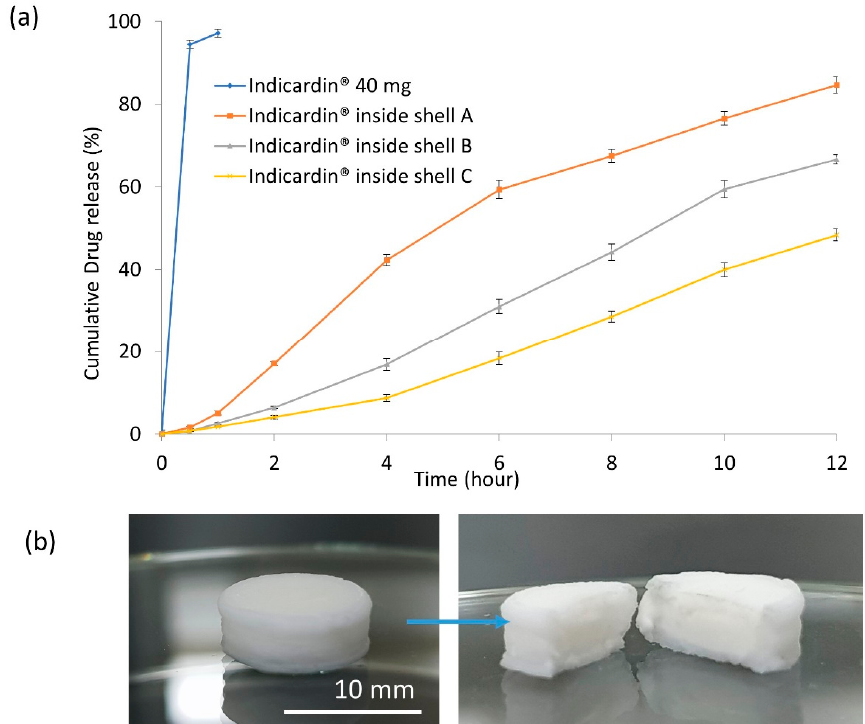
Table 3. Influence of different compositions of 3D printed controlled-release shell on % cumulative drug release after 12 h with phosphate buffer (pH 6.8) as dissolution media at a temperature of 37 ± 0.5 °C.